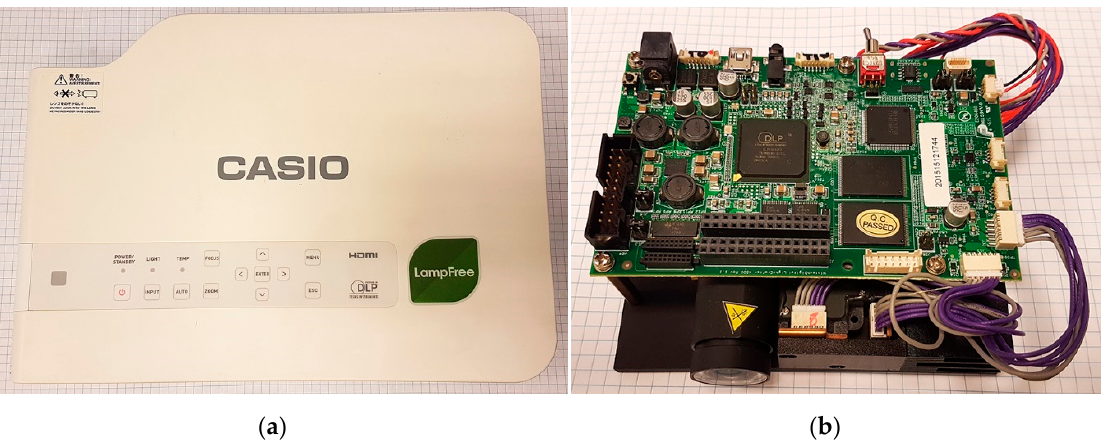
Figure 1. The projectors used in the experiments: ( a ) business-class projector DLP Casio XJ-A252; and ( b ) development kit projector DLPLightCrafter 4500.